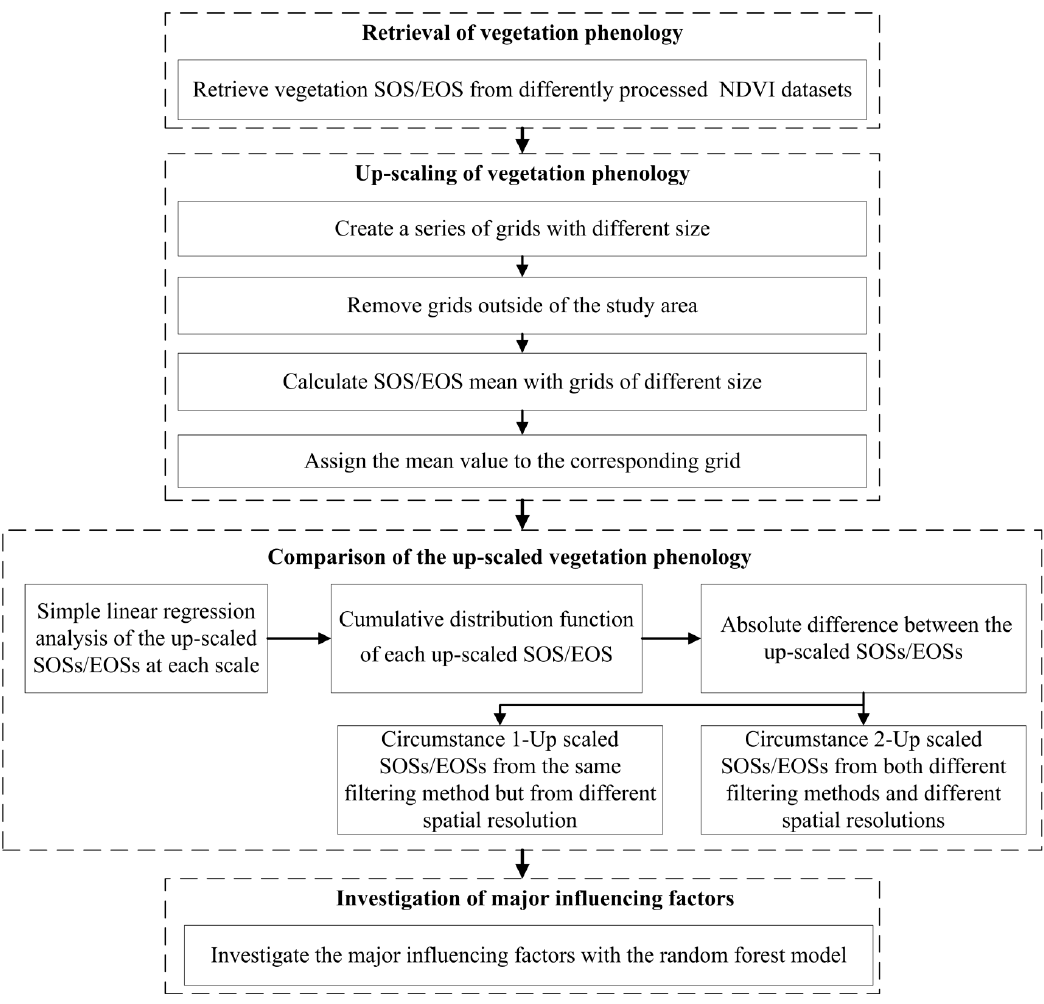
Figure 4. Flowchart for investigating the spatial scale effects of vegetation phenology.